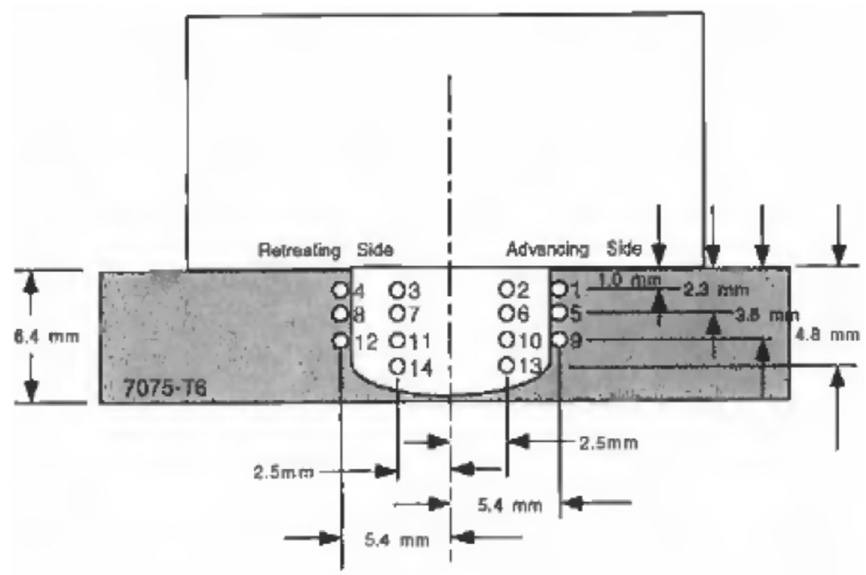
Figure 6: Tracer line positions for the 6.4 mm 7075-T6 plate. The groove containing the steel shot tracer material was ori- ented at various positions relative to the welding tool pin and at various depths in the work piece plate, as shown in this schematic.